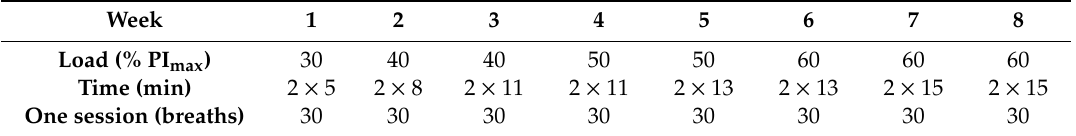
Table 3. Inspiratory muscle training.